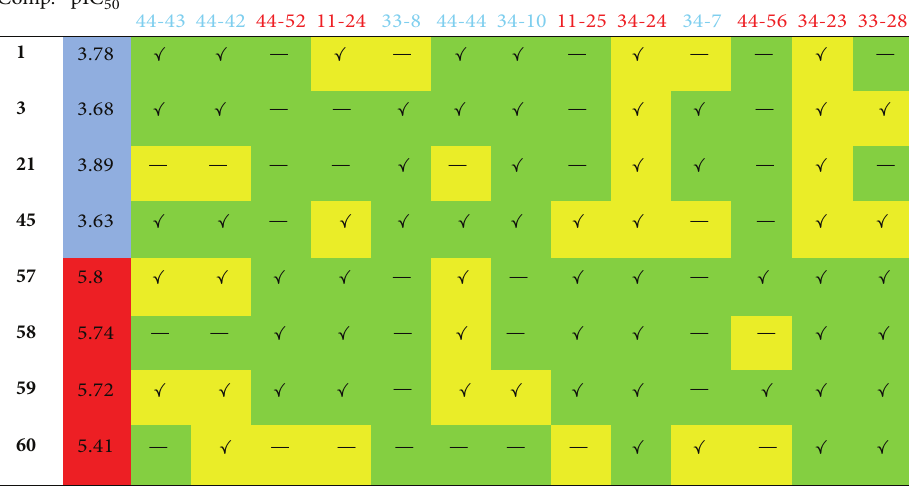
Figure 5: Visual inspection of variables to identify the most discriminative ones. Red and blue boxes include active and inactive compounds, respectively. The numbers written in red represent the variables which have a high positive impact on antitumor activity and the variables with a significant negative impact are written in blue. If a variable is present ( ✓ ) or absent (—) in a compound as expected, the relative box is highlighted in green; otherwise it is highlighted in yellow.